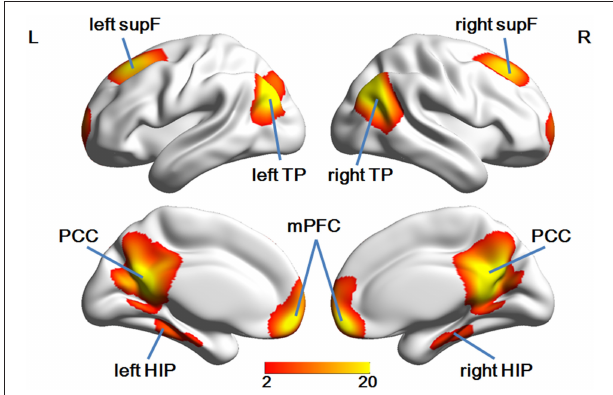
FIGURE 3 | The eight ROIs identified in the DMN